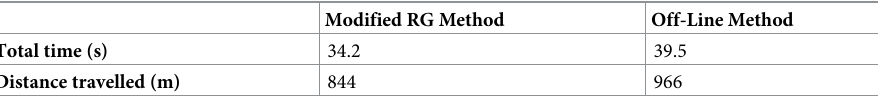
Table 8. Basic overtaking parameters for scenario 2 –a comparison.